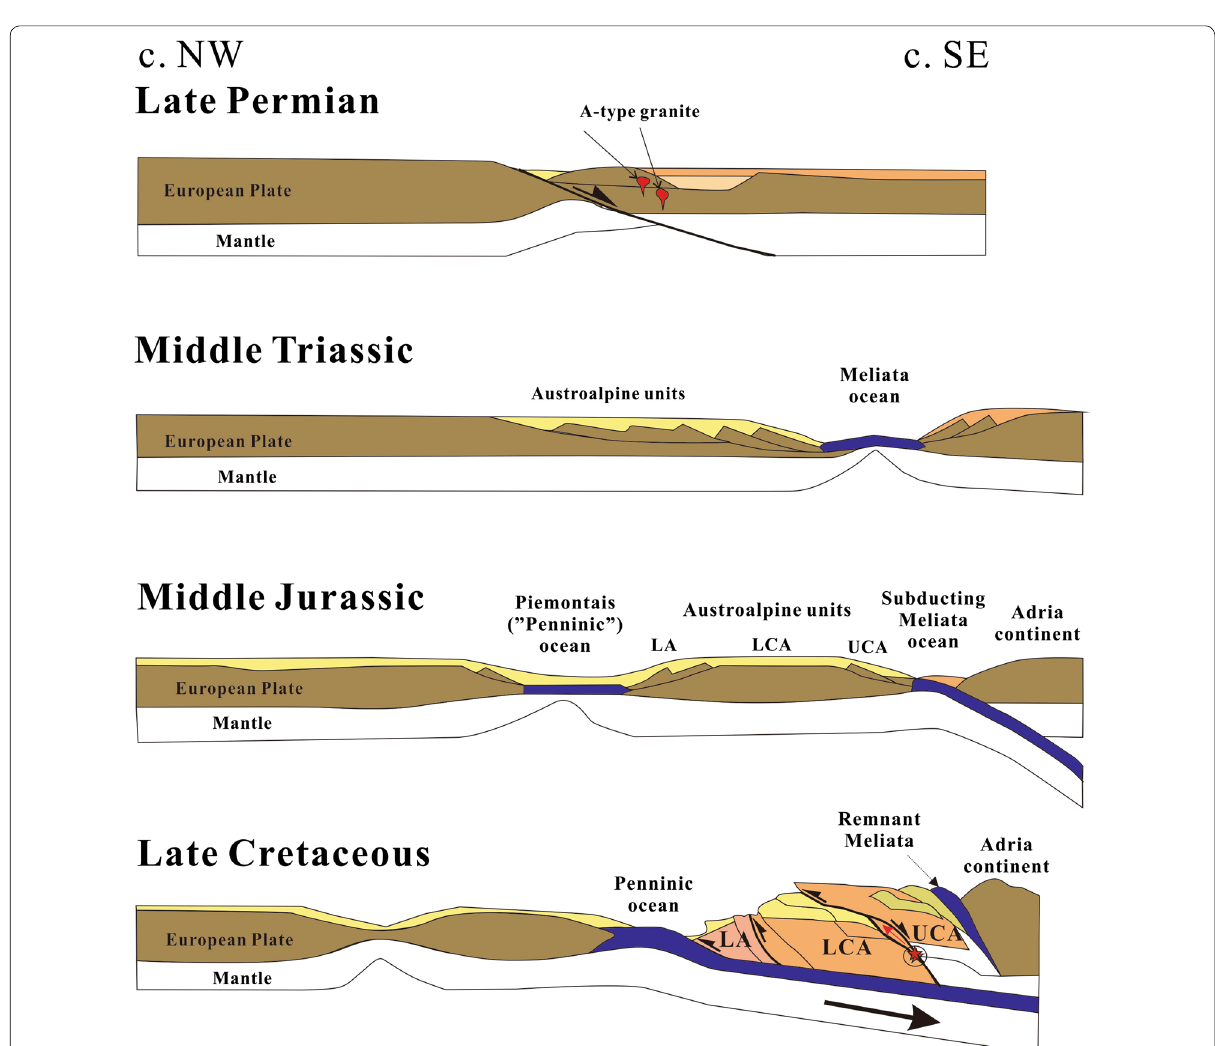
Fig. 14 Model of tectonic evolution in Pohorje from Eastern Alps. LA, Lower Austroalpine domain; LCA, Lower Central Austroalpine domain; UCA, Upper Central Austroalpine